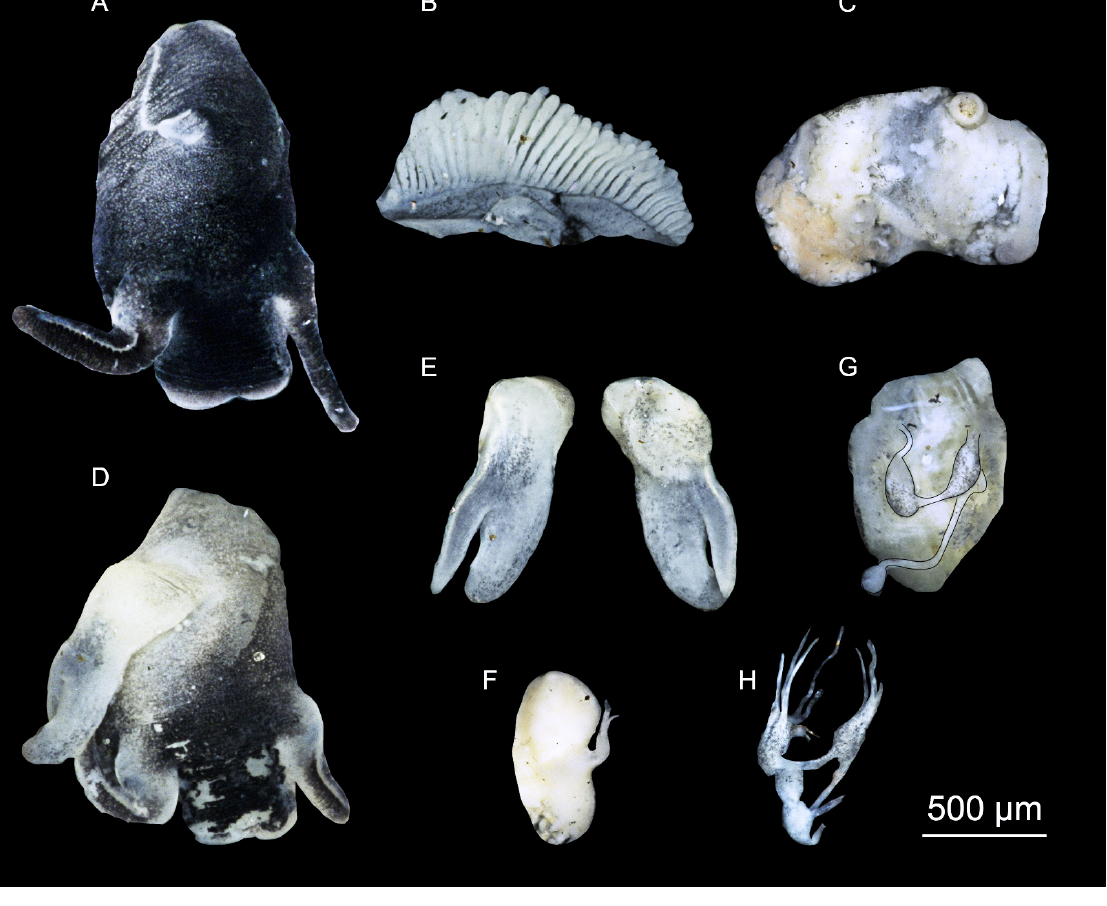
Fig. 31. Anatomy of the Mercuria veronicae Miller, Khalloufi & Delicado sp. nov. from Spring El Waha, Tozeur, Tunisia. A . Head. B . Ctenidium and osphradium. C . Stomach. D . Head of a male. E . Penis. F . Prostate gland. G . Head with perioesophageal ring attached. H . Perioesophageal